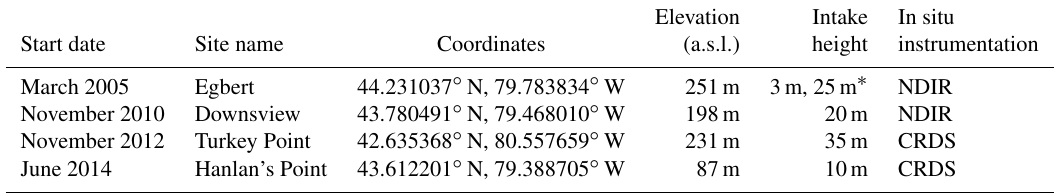
Table 1. Summary of atmospheric measurement programs in Southern Canada operated by Environment and Climate Change